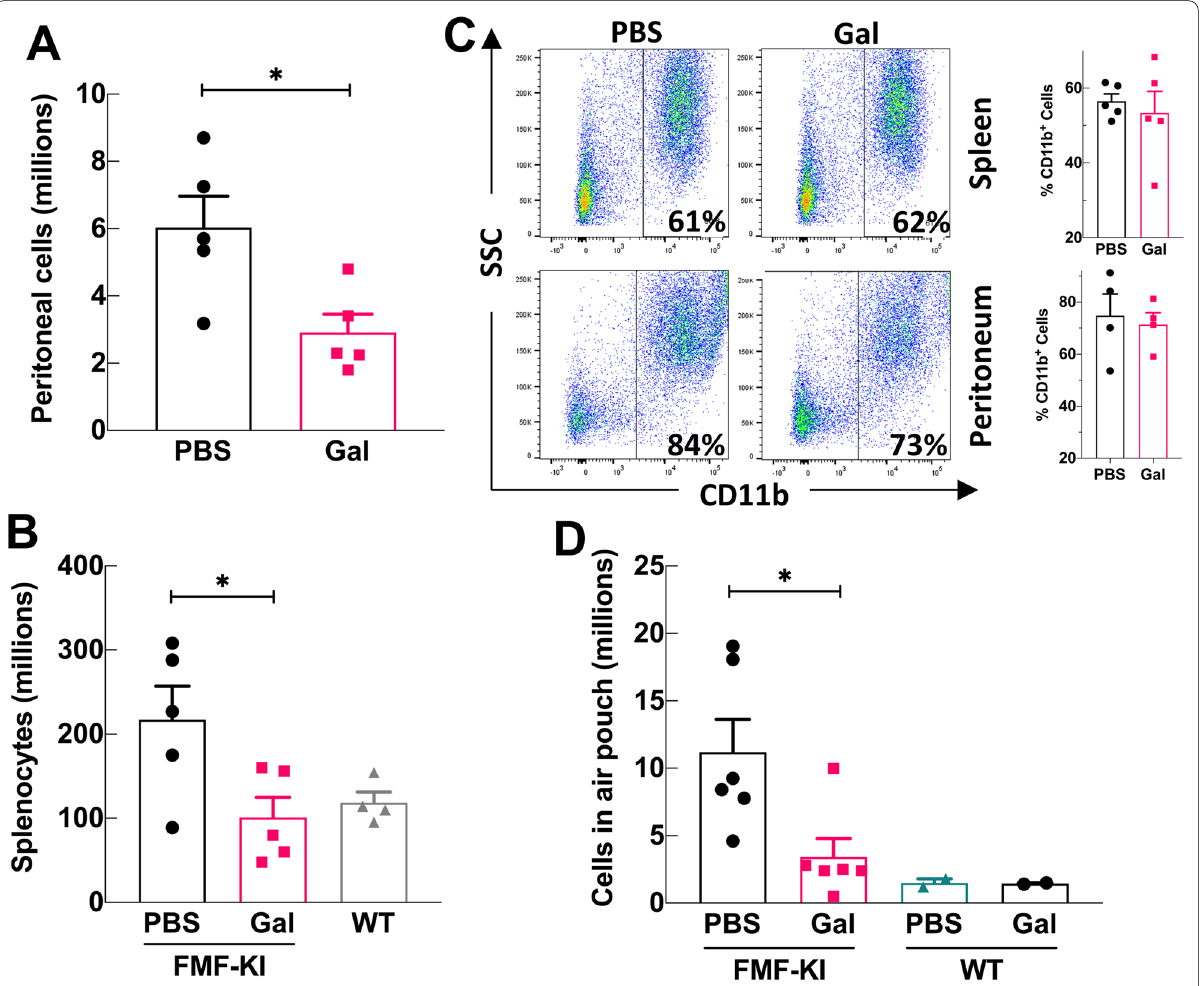
Fig. 2 Galantamine‑treatment inhibits leukocyte trafficking to inflammatory sites in FMF‑KI mice. A , B Total number of cells in peritoneal washes ( A ) and total splenocyte counts ( B ) from galantamine‑ and PBS‑treated FMF‑KI mice at the end of 4–8 weeks of treatment (data presented as mean SEM; * P < 0.5 by Mann–Whitney U test). C Example flow cytometric analysis of splenic and peritoneal cells from galantamine‑ and ± PBS‑treated FMF‑KI mice after 4–8 weeks of treatment. Total splenocytes were analyzed for relative frequencies of CD11b + . The percentage of CD11b + cells from the spleens of galantamine‑ and PBS‑treated FMF‑KI mice (n 5 in each group) is shown next to the flowcytometry panels. D = Total number of cells in a subcutaneous dorsal air pouch from galantamine‑ and PBS‑treated FMF‑KI mice after 6 days of treatment (data presented as mean SEM; * P < 0.05 by Mann–Whitney U test; WT is included for comparison ±